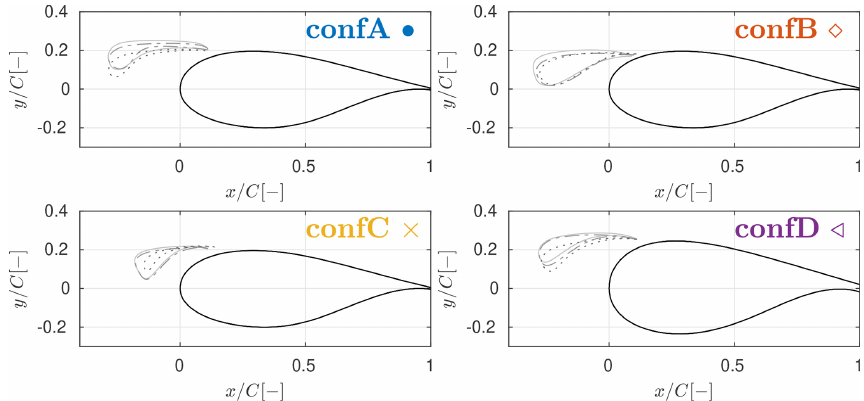
Figure 7. Designs obtained using the auxiliary design procedure optimized for maximum lift ( − ), maximum glide ratio ( : ), and a combination of both ( − . ); see Fig. 8 for clarification.